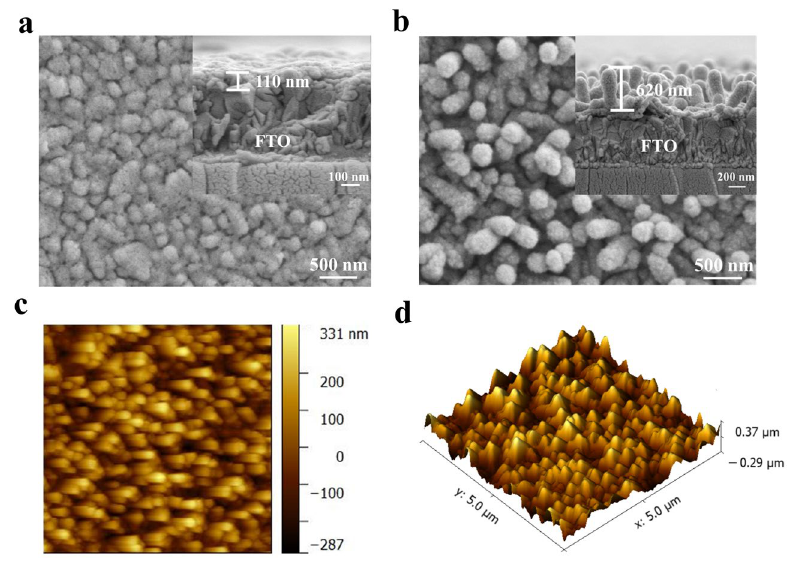
Figure 2. SEM images of ( a ) FTO–P 2 W 17 La and ( b ) NW–P 2 W 17 La composite films (insets: cross-sectional images). ( c ) Two-dimensional (2D) and ( d ) 3D AFM images of the NW–P 2 W 17 La composite film.